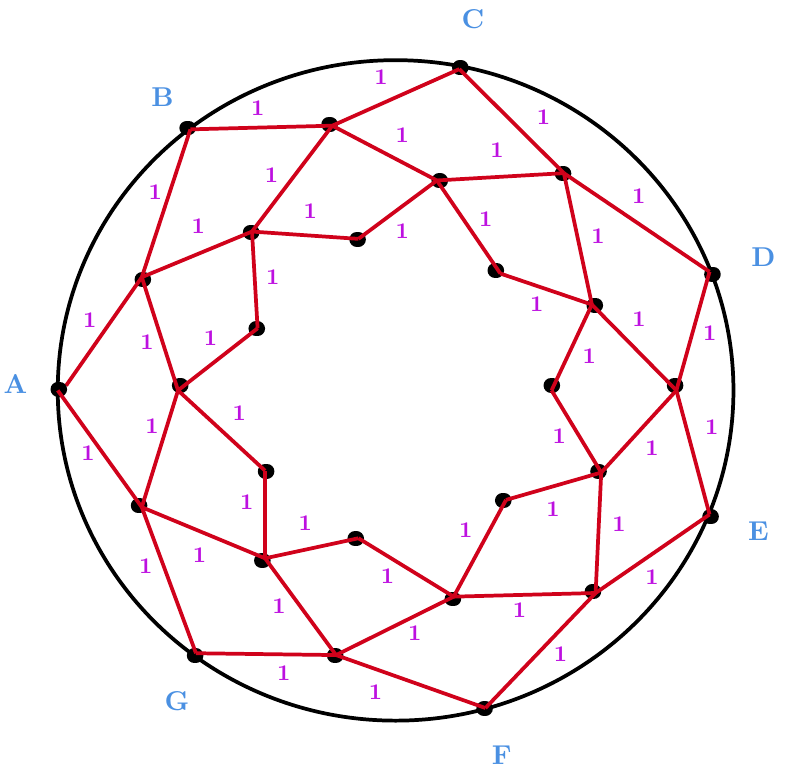
Figure 13 . The 7 -region diamondwork graph with constant edge